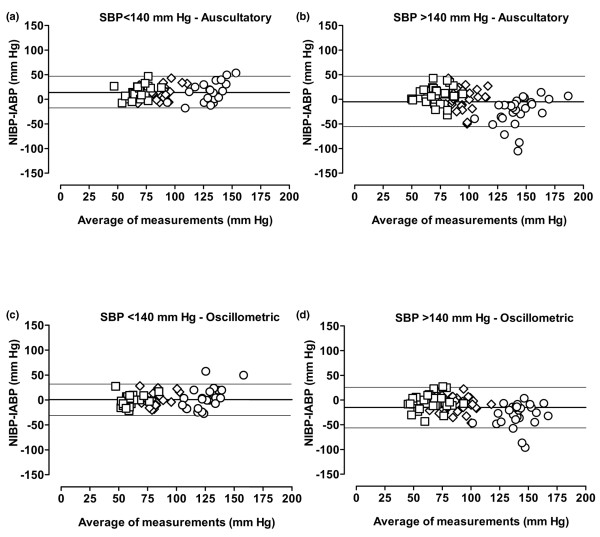
Agreement between auscultatory and oscillometric, and intra-arterial blood pressure measurements: effect of SBP. Shown are graphs of measurement in patients with (a) SBP <140 mmHg and (b) SBP ≥140 mmHg by auscultatory technique, and in patients with (c) SBP <140 mmHg and (d) SBP ≥140 mmHg by oscillometric technique. A total of 23 patients had SBP <140 mmHg and 31 had SBP ≥140 mmHg. The thicker line represents mean bias, and the thinner lines represent upper and lower limits of agreement. Squares are diastolic blood pressure measurement, diamonds are mean arterial blood pressure measurements, and circles are systolic blood pressure measurements. IABP, intra-arterial blood pressure; NIBP, noninvasive blood pressure; SBP, systolic blood pressure.